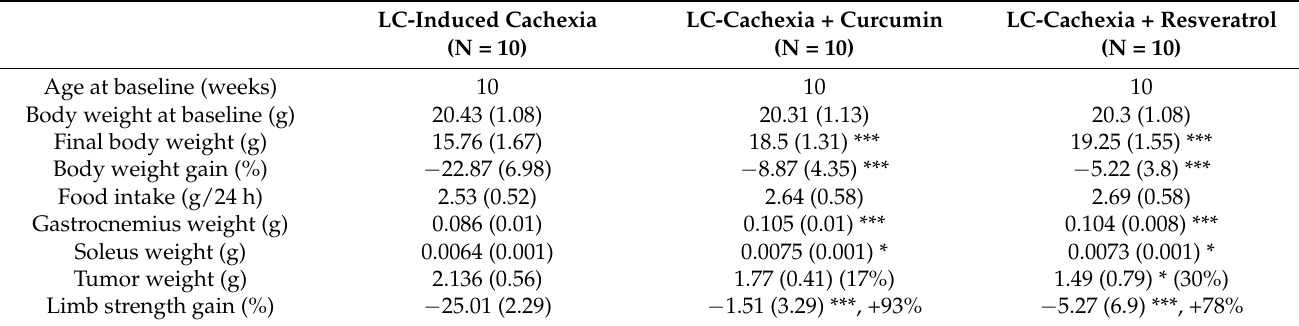
Table 1. Physiological parameters in the experimental groups of